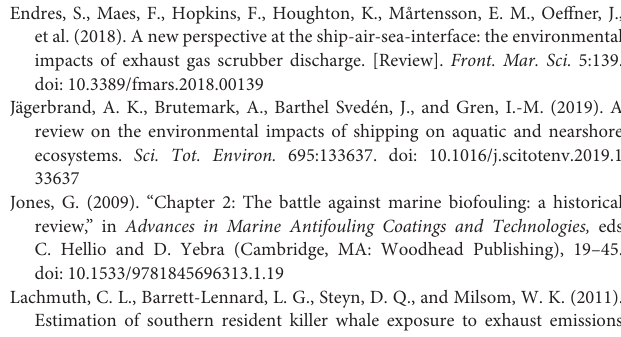
Figure 2 . All authors summarized 5, 6 articles each and approved the final version of this